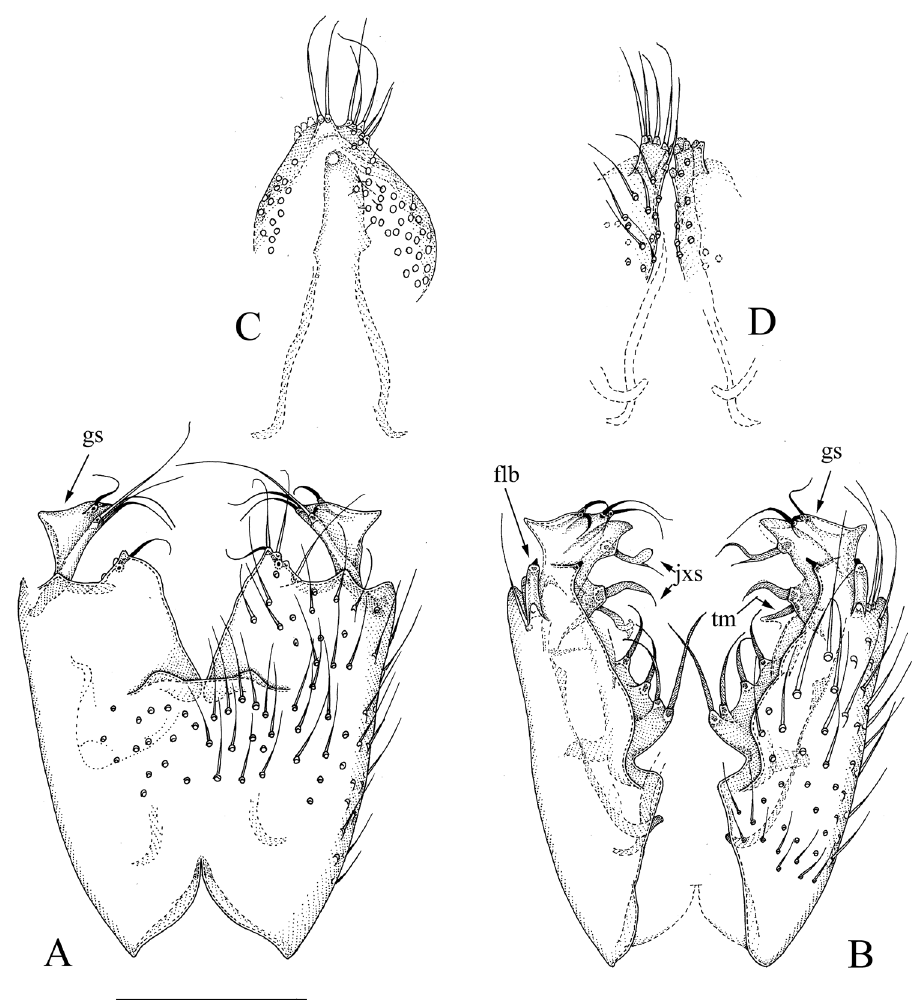
Figure 3. Manota perplexa sp. n. (holotype). A Hypopygium, ventral view B Hypopygium dorsal view C Aedeagus and hypoproct, ventral view D Cerci with associated parts, dorsal view. Scale bar 0.10 mm. Abbreviations: flb = finger-like lobe, gs = gonostylus, jxs = juxtagonostylar megasetae, tm = twisted megaseta. Anepisternum with 46 setae; anterior basalare, preepisternum 2 and laterotergite non- setose; metepisternum with 15 setae on anterior part. Legs. Mid and hind tibial organs absent. Wing. R meeting C within basal half of costal margin; sclerotized part of 1 M extending to level of tip of R ; wing length 1.6 mm. Hypopygium (Fig. 3A–D). 2 1 Sternite 9 laterally entirely fused to gonocoxa, posterior margin free with protrud- ing posterolateral corners; setae similar to adjacent ventral setae of gonocoxa. Ventral medial margin of gonocoxa simple, posteromedial corner drawn into a lobe, postero- lateral part of gonocoxa not drawn into a lobe. Parastylar lobe indistinct,